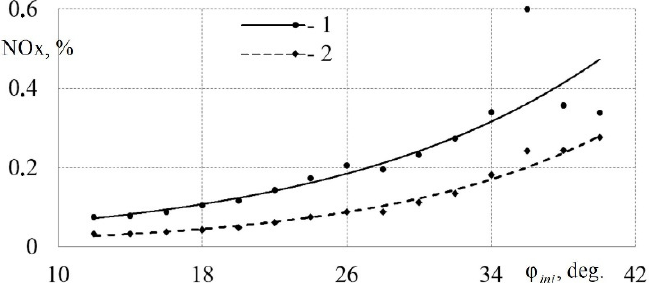
Figure 13. Dependence of the amount of NOx emissions on the fuel injection advance angle φ inj for different operating modes: 1—position No. 1 (idle); 2—rated power.